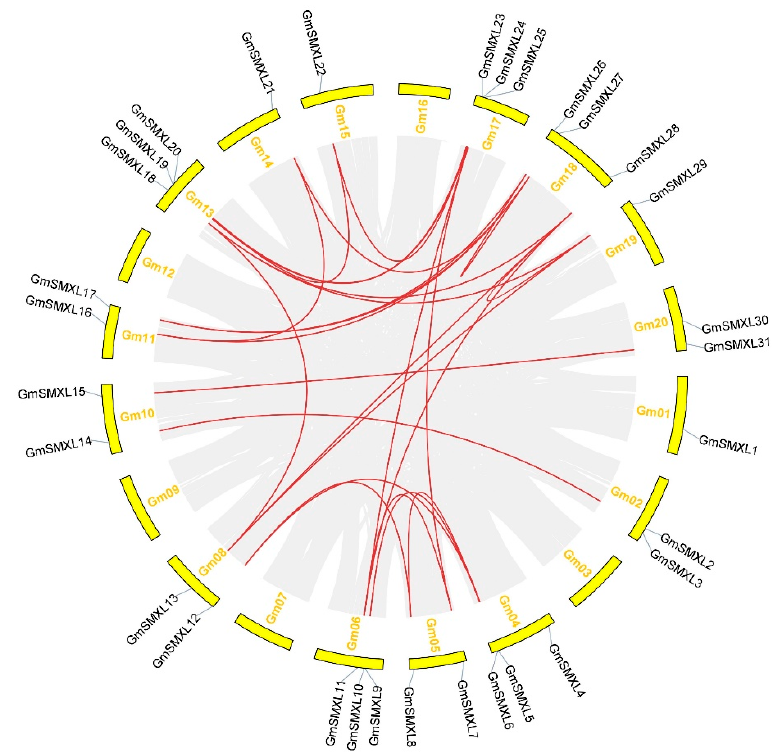
Figure 4. Collinearity analysis of the whole soybean genome and SMXL family genes. The gray lines in the middle represent the soybean genome’s collinearity module, and the red lines show that some of the GmSMXL genes have a collinear relationship.